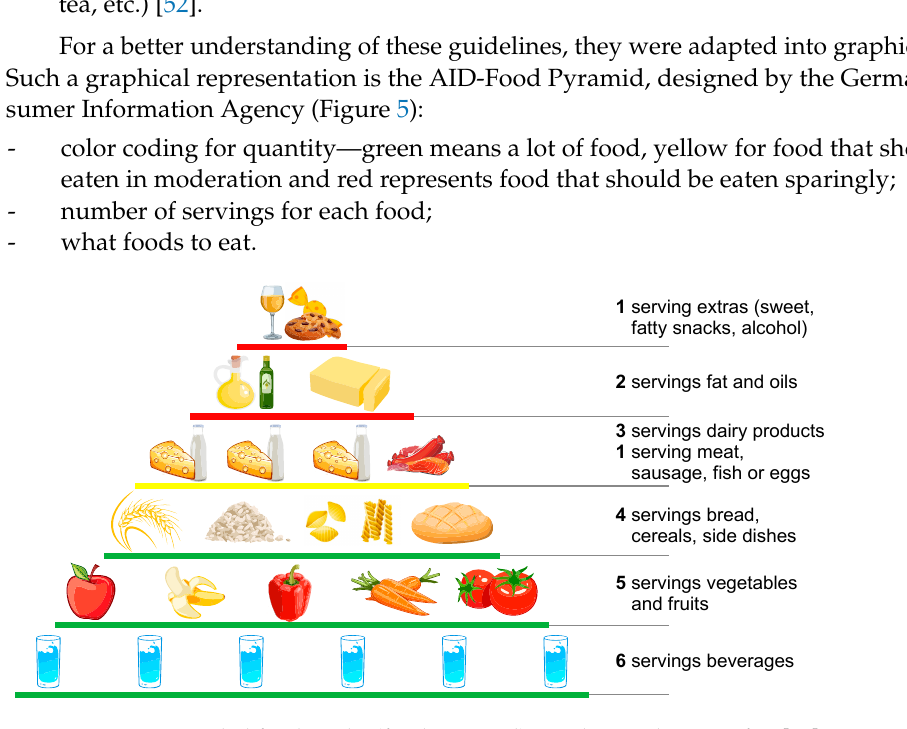
Figure 5. Recommended food intake (food pyramid)—authors’ adaption after [52].